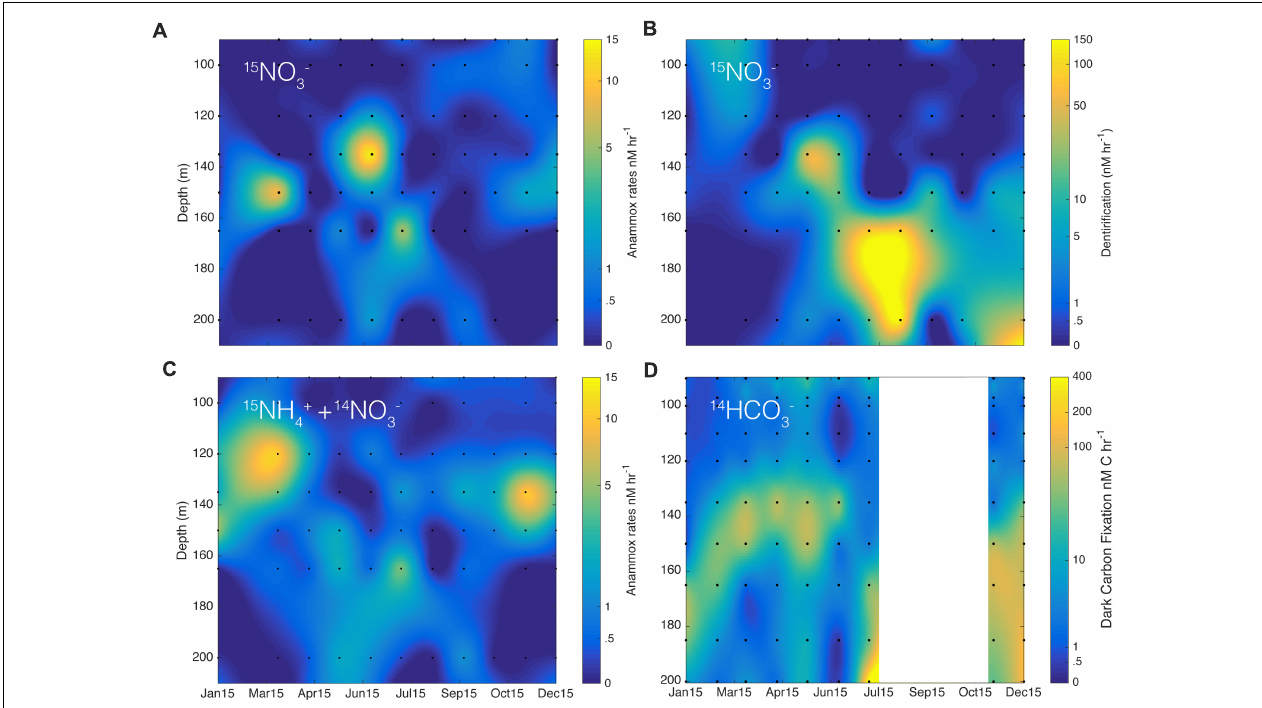
FIGURE 3 | Potential rates of (A) anammox (nM hr − 1 ) and (B) denitrification (nM hr − 1 ) calculated from the incubated samples with 15 NO 3 − for the year 2015 at station S3. (C) Shows potential rates of anammox of samples incubated with 15 NH 4 + + 14 NO 3 − . In (D) , graph shows rates of dark carbon fixation from incubation with H 14 CO 3 − in nM hr − 1 . The scale bar is in log